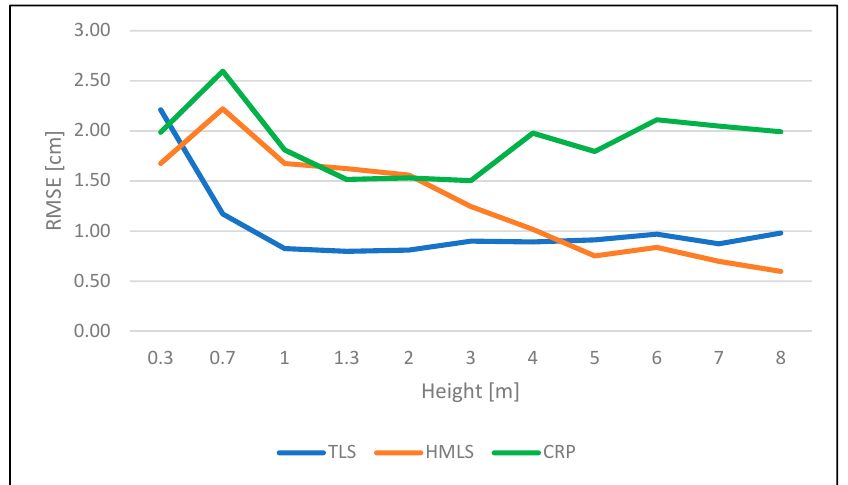
Figure 8. Root mean squared error of diameter estimation at different heights.